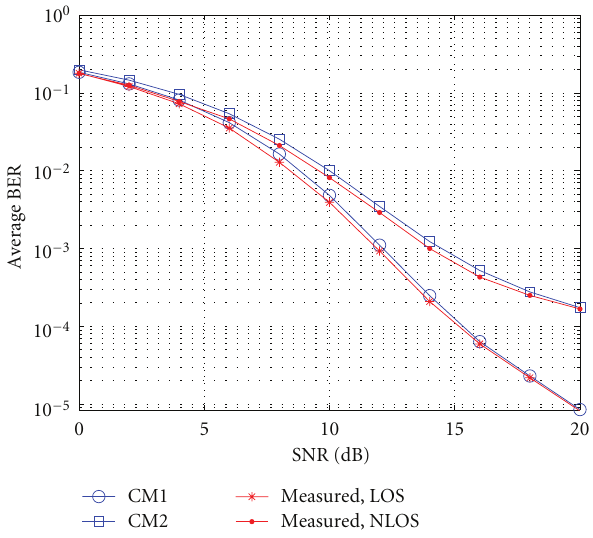
Figure 4: BER performance comparison, for standard channels with ρ Tx = 0 . 2 and for measured indoor